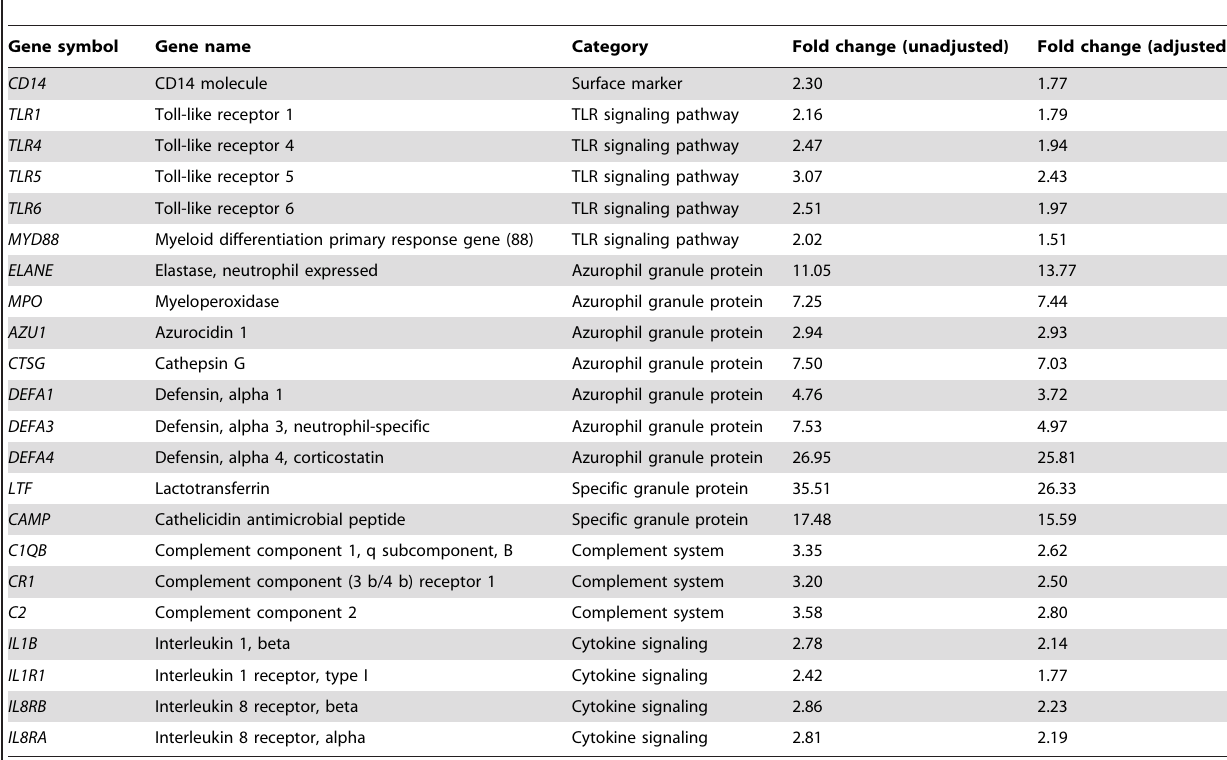
Table 4. Select list of genes involved in defense response that were upregulated in third trimester pregnant women at the end of the controlled feeding study.